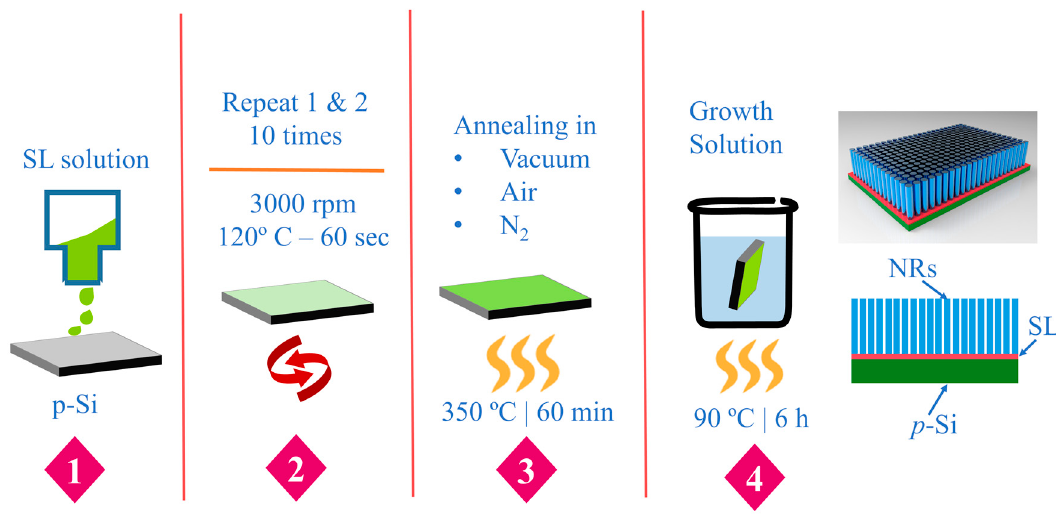
Figure 1. Process flow of ZnO nanorods (NRs) growth with three different post-annealing ambient conditions (vacuum, air and N 2 ) for the seed layers (SLs).